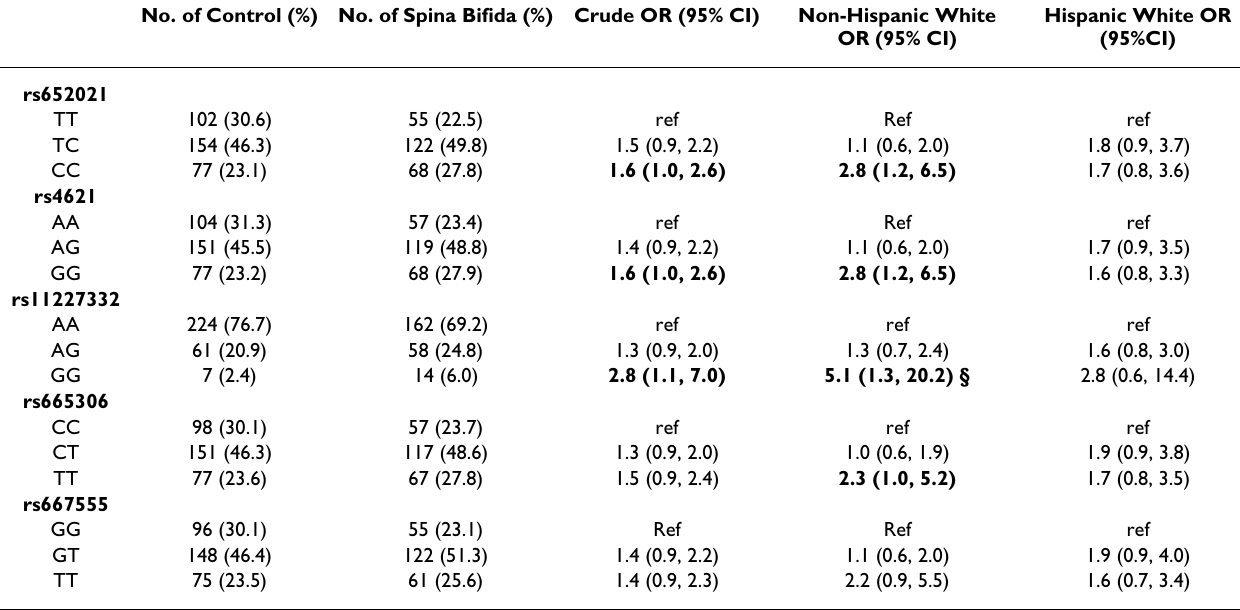
Table 5: Association between CFL1 genotypes and spina bifida risk: Odds Ratio estimation by Logistic Regression No. of Control (%) No. of Spina Bifida (%) Crude OR (95%